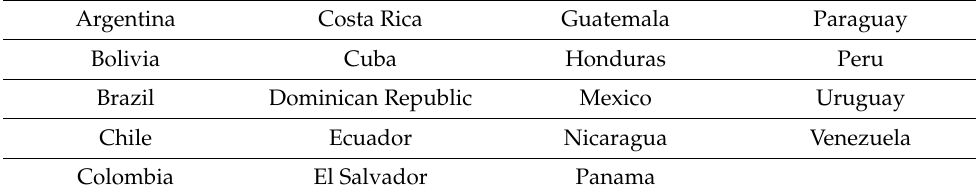
Table A2. Latin America (including Cuba and the Dominican Republic)—19 Countries.